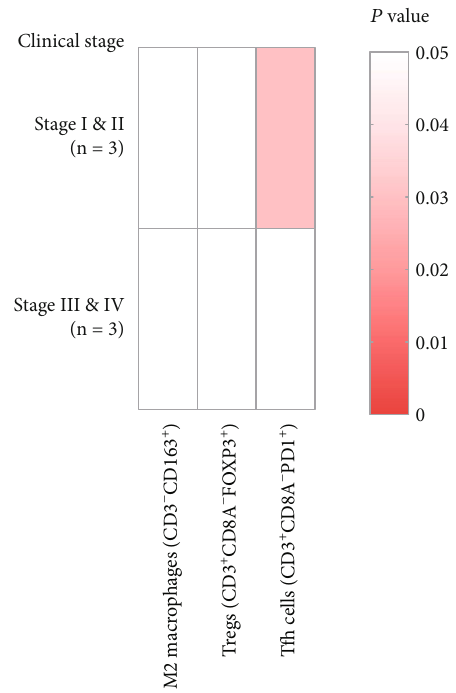
Figure 4: The expression of M2 macrophages (CD3-/CD163+), Tregs (CD3+/CD8A-/FoxP3+), and Tfh cells (CD3+/CD8A-/PD1 +) in SN and NSN of patients at di ff erent clinical